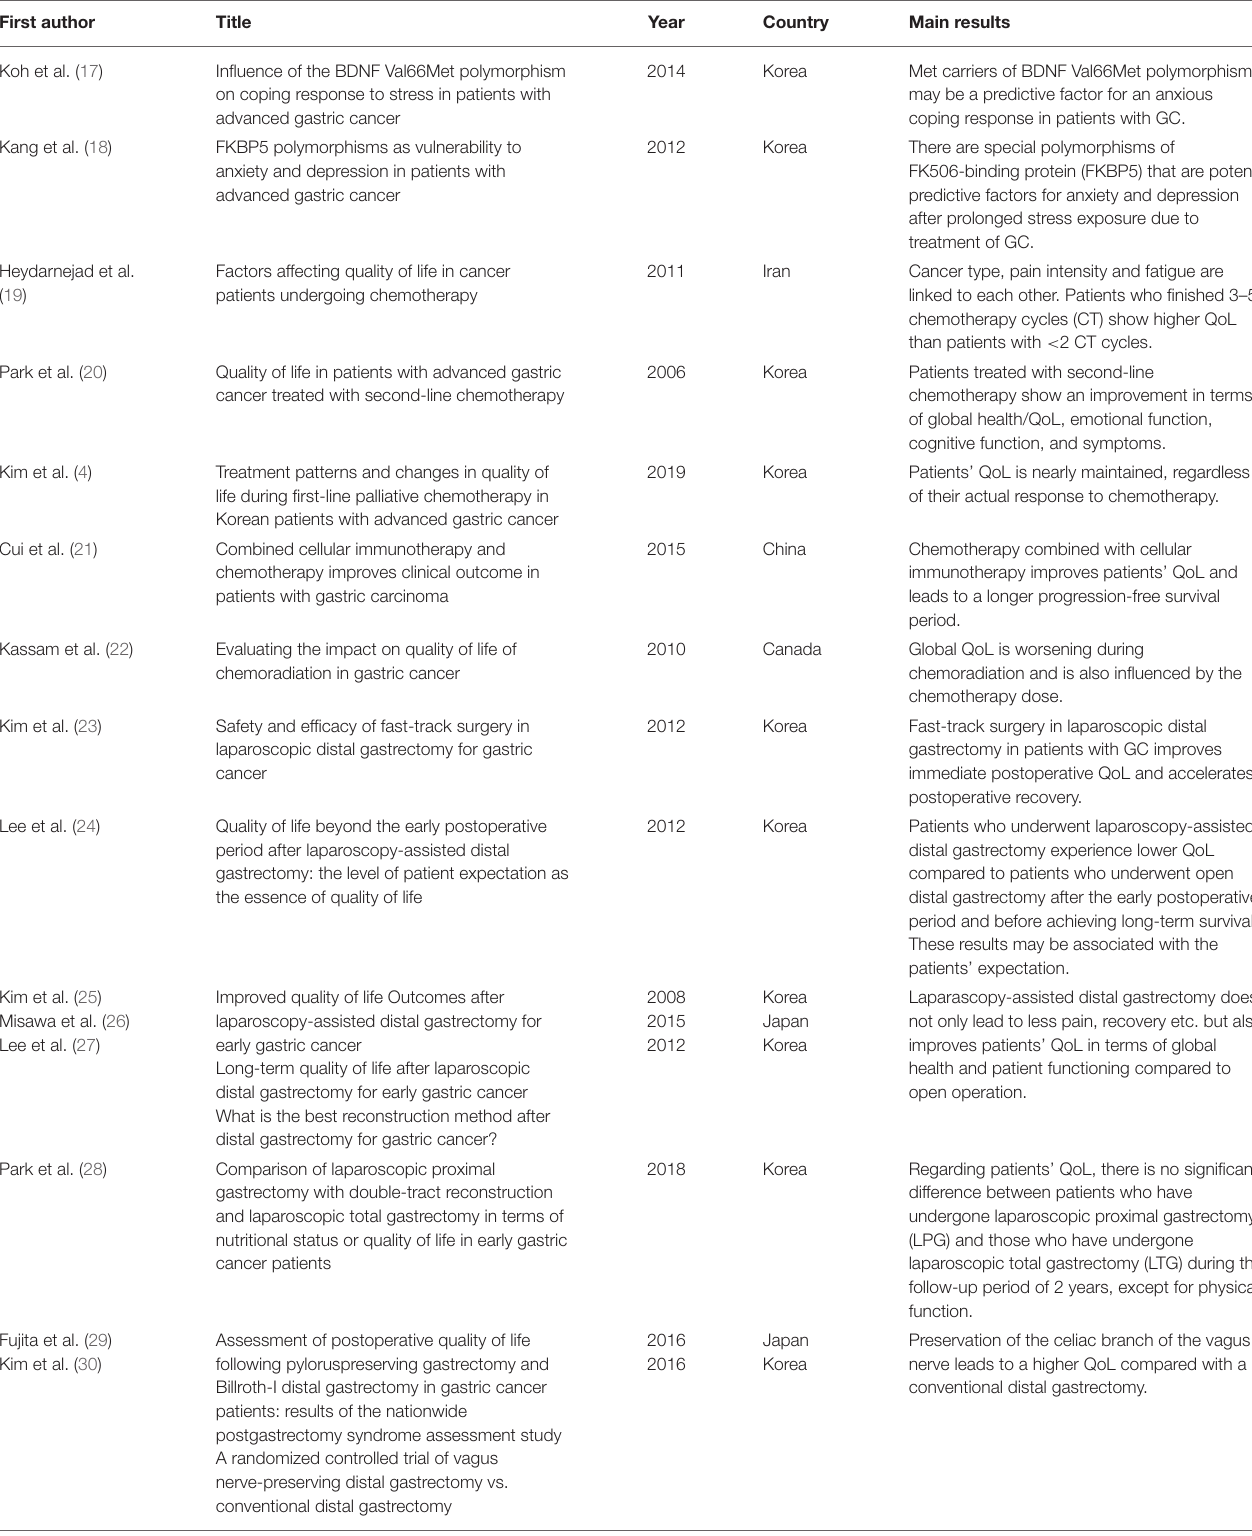
TABLE 2 | Main results of articles discussed in this systematic review (in order of